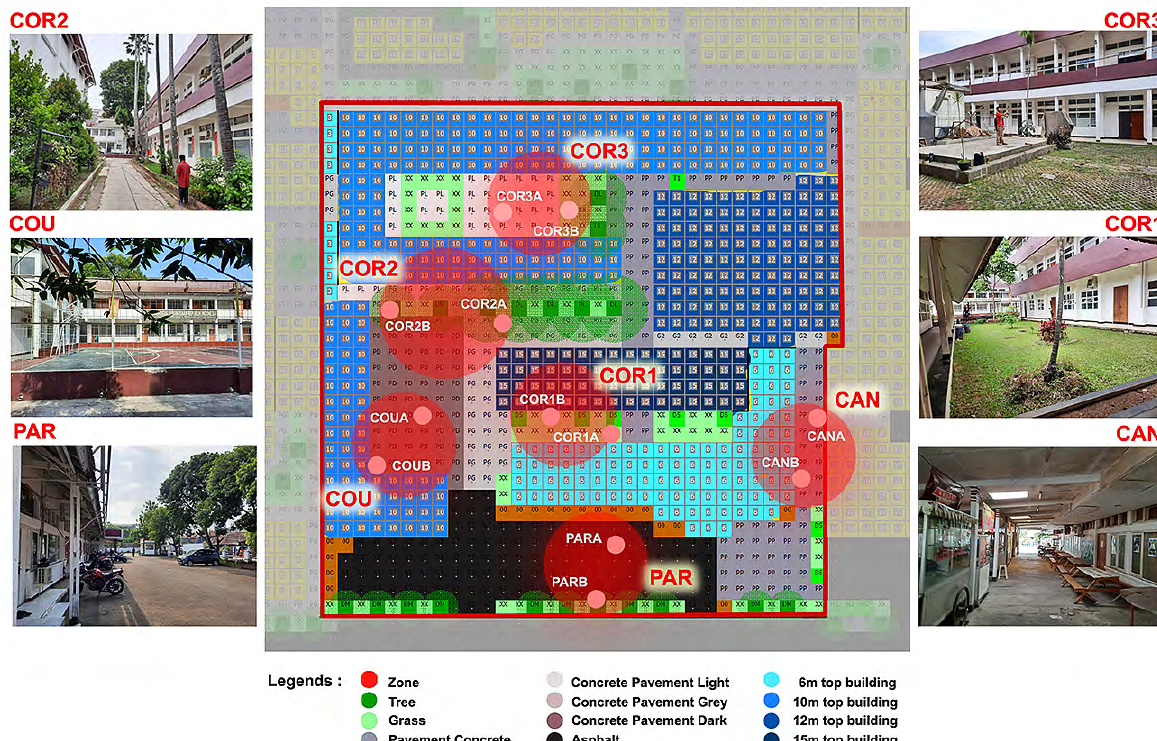
Figure 4. The outdoor zone division in the case